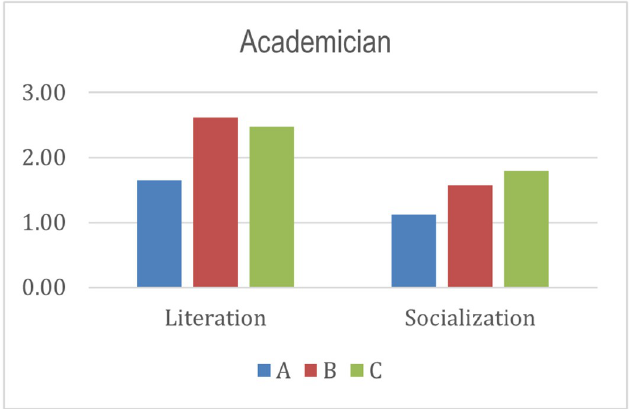
Fig 9. Index score of academician.